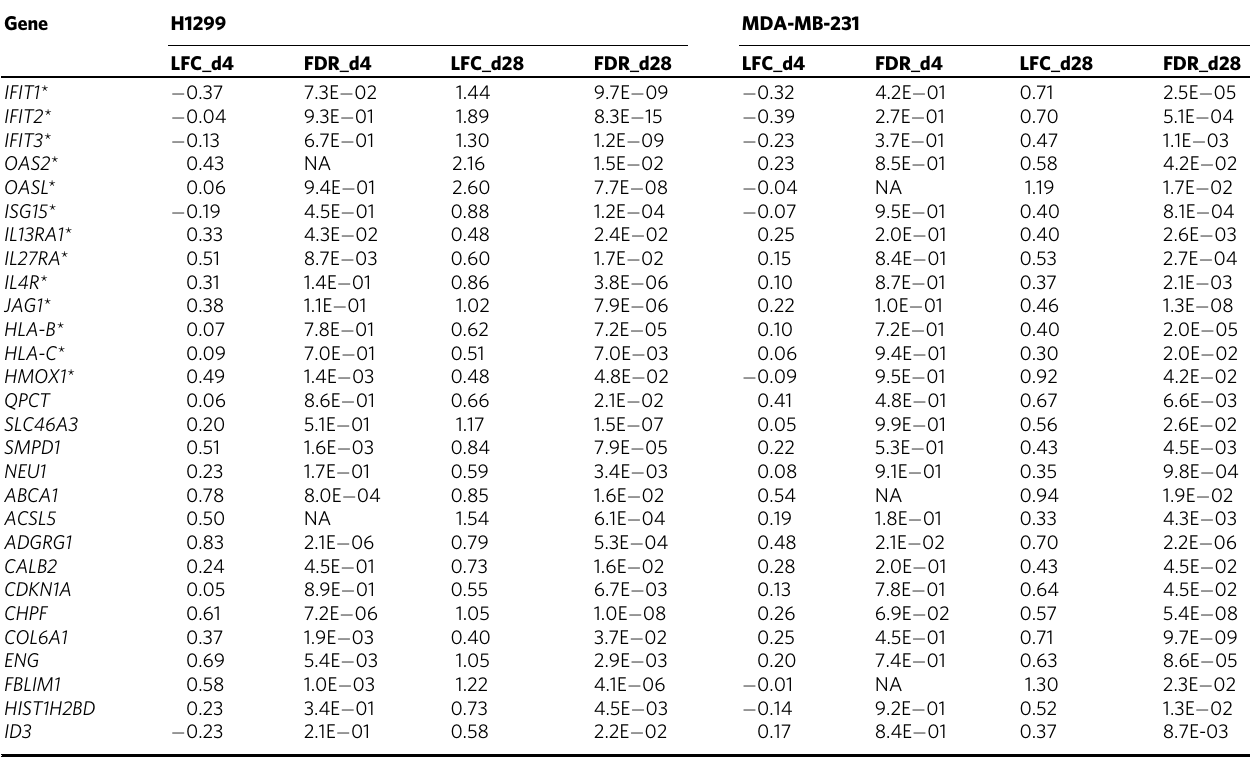
Table 1 List of 28 genes commonly upregulated in H1299 and MDA-MB-231 Gene